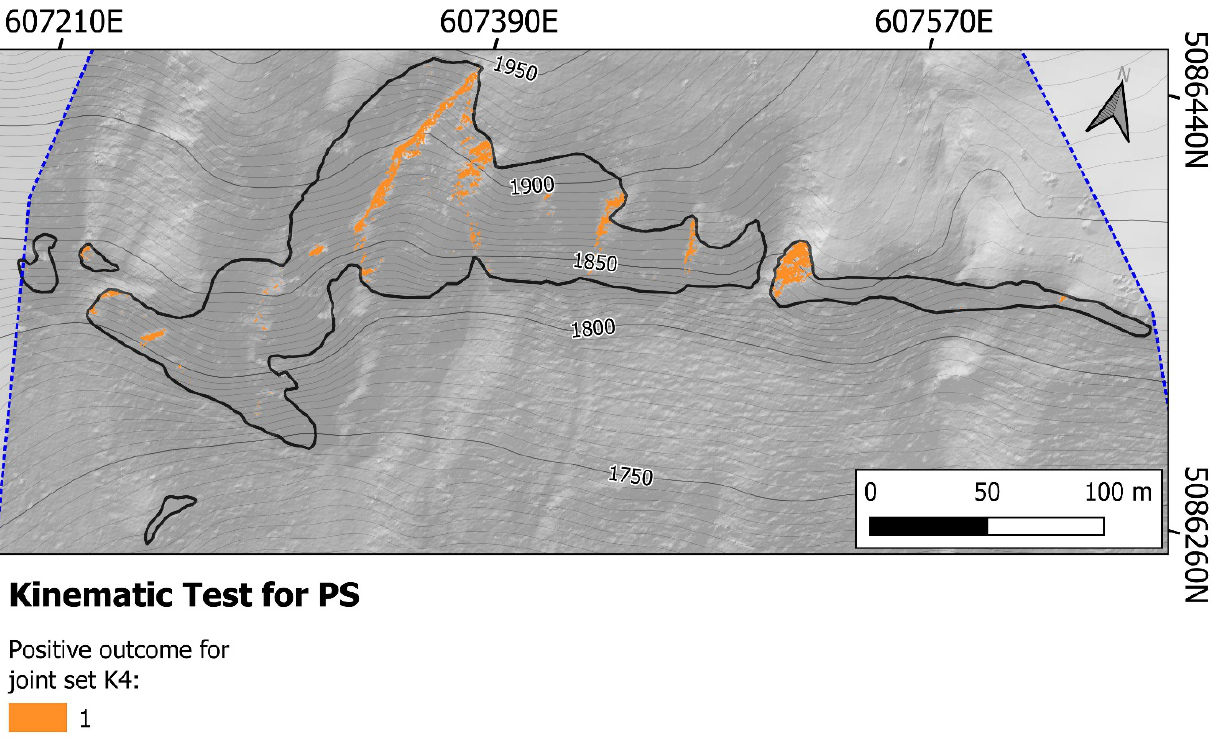
Figure A4. Image of the partial output file showing the kinematic test for PS performed considering only joint set K4.